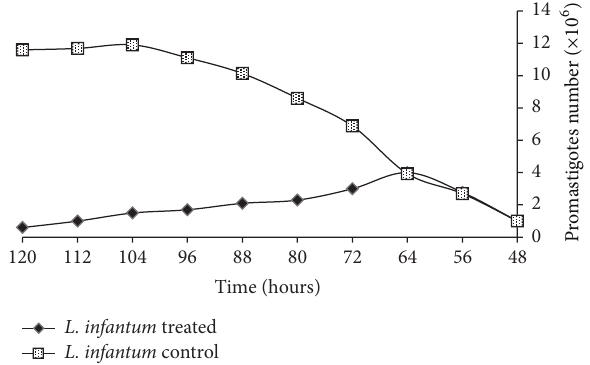
Figure 3: Antileishmanial activities of coelomic fluid extract of H. leucospilota against L. infantum promastigotes. Number of promastigotes treated with or without coelomic fluid (22.5 𝜇 g/mL) at different time point after 48